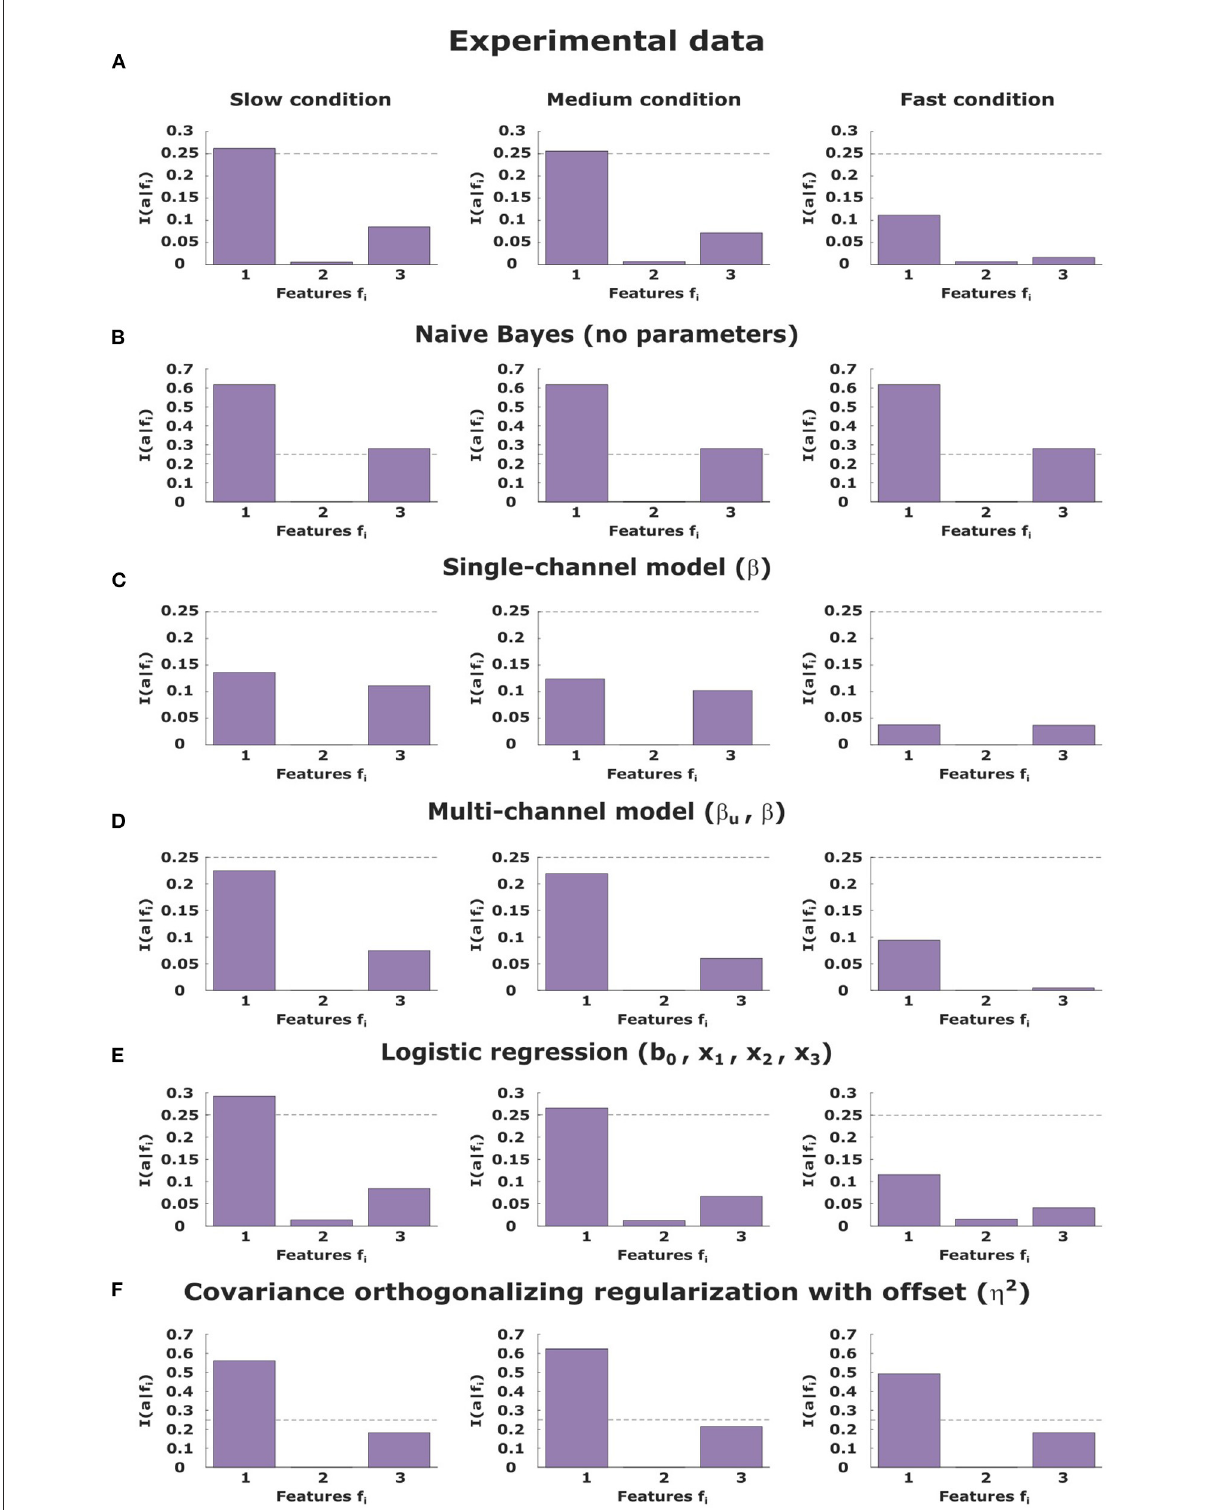
FIGURE9 Mutual information between the three stimulus features and the decision-maker’s choice as recorded experimentally (A) and compared to model fits of a naive Bayes-optimal model (B) , a single information channel model (C) and a bounded rational model with multiple feature-specific information channels (D) , a logistic regression (E) and the bounded rational regression model (F) by Parpart et al.